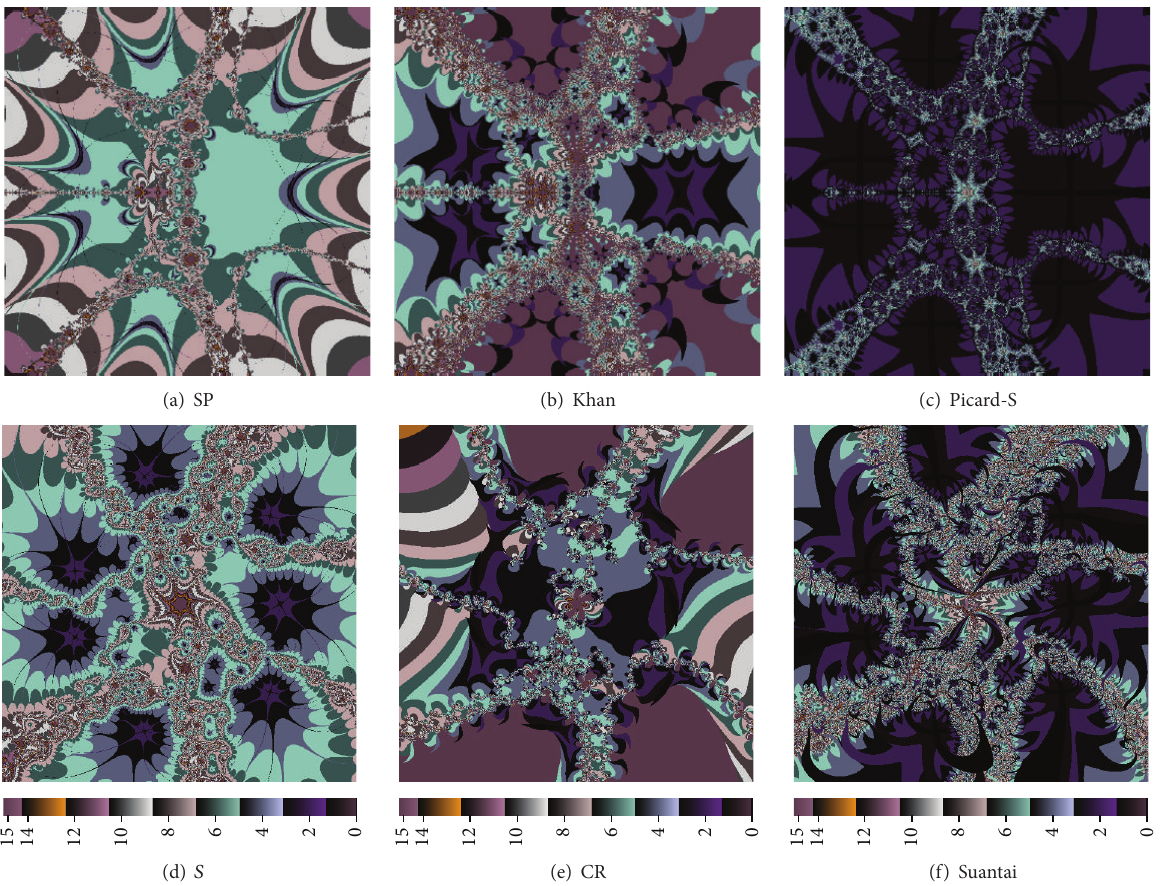
Figure 6: Examples of different convergence tests application for 𝑝 1 , the iterations with: real-valued parameters (a, b, and c) and complex- valued parameters (d, e, and